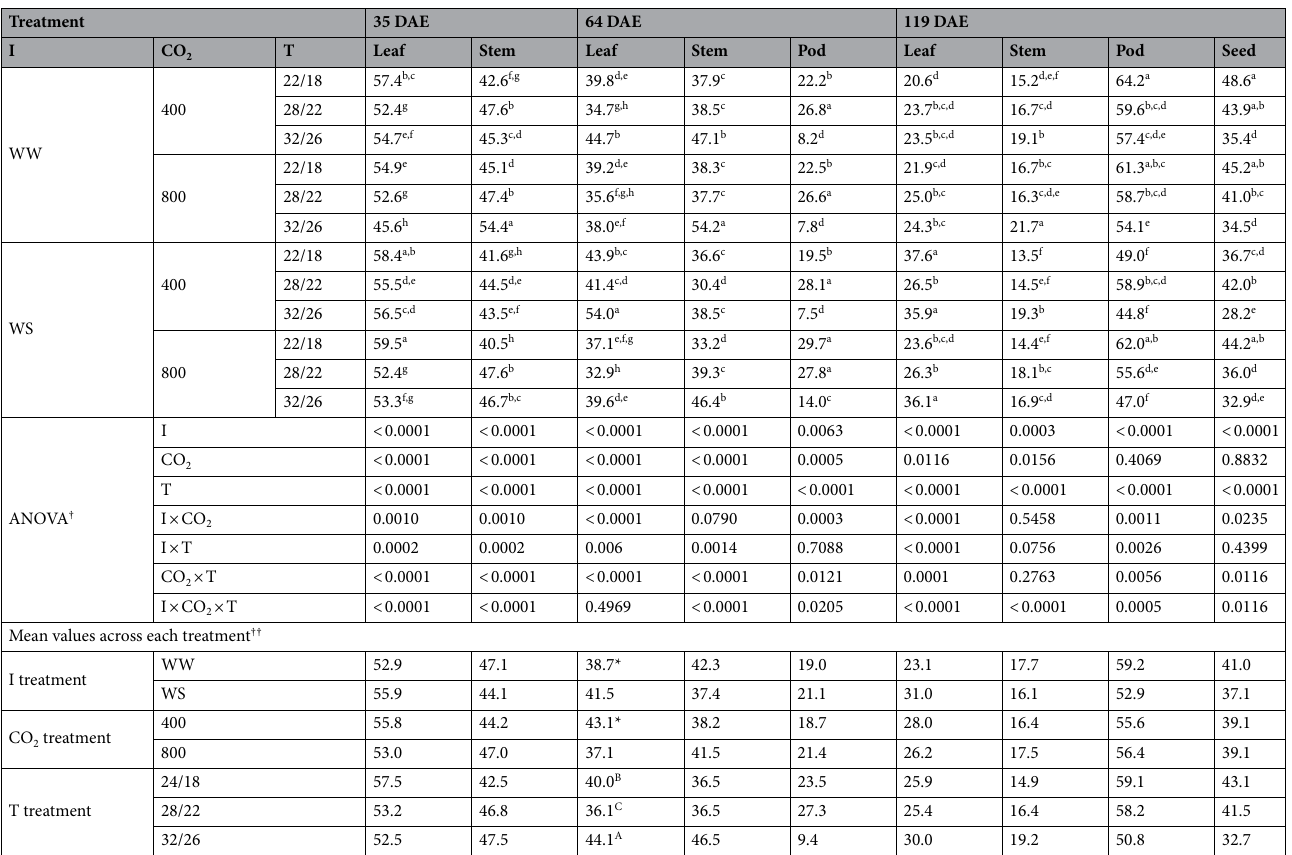
Table 3. Effects of irrigation (I, WW, well water; WS, water stress), CO 2 levels (µmol mol −1 ), and temperature (T, day/night, °C) treatments on the dry mass partition in leaves, stems, pods and seeds (%) at 35, 64 and 118 days after emergence (DAE). † The significance test (P-values) of the analysis of variance (ANOVA) across treatments and interactions are given. When the I × CO 2 × T interaction is significant, within a column means followed by the same lowercase letter are not significantly different. †† The means across each treatment is also given. When I × CO 2 × T interaction is not significant, the symbol * indicates a significant difference between values within either I or CO 2 treatments, and the mean value between T treatments followed by the same uppercase letter is not significant. Data are the mean (n = 18, 12, and 15 for 35, 64 and 119 DAE, respectively). Least significant difference at α =